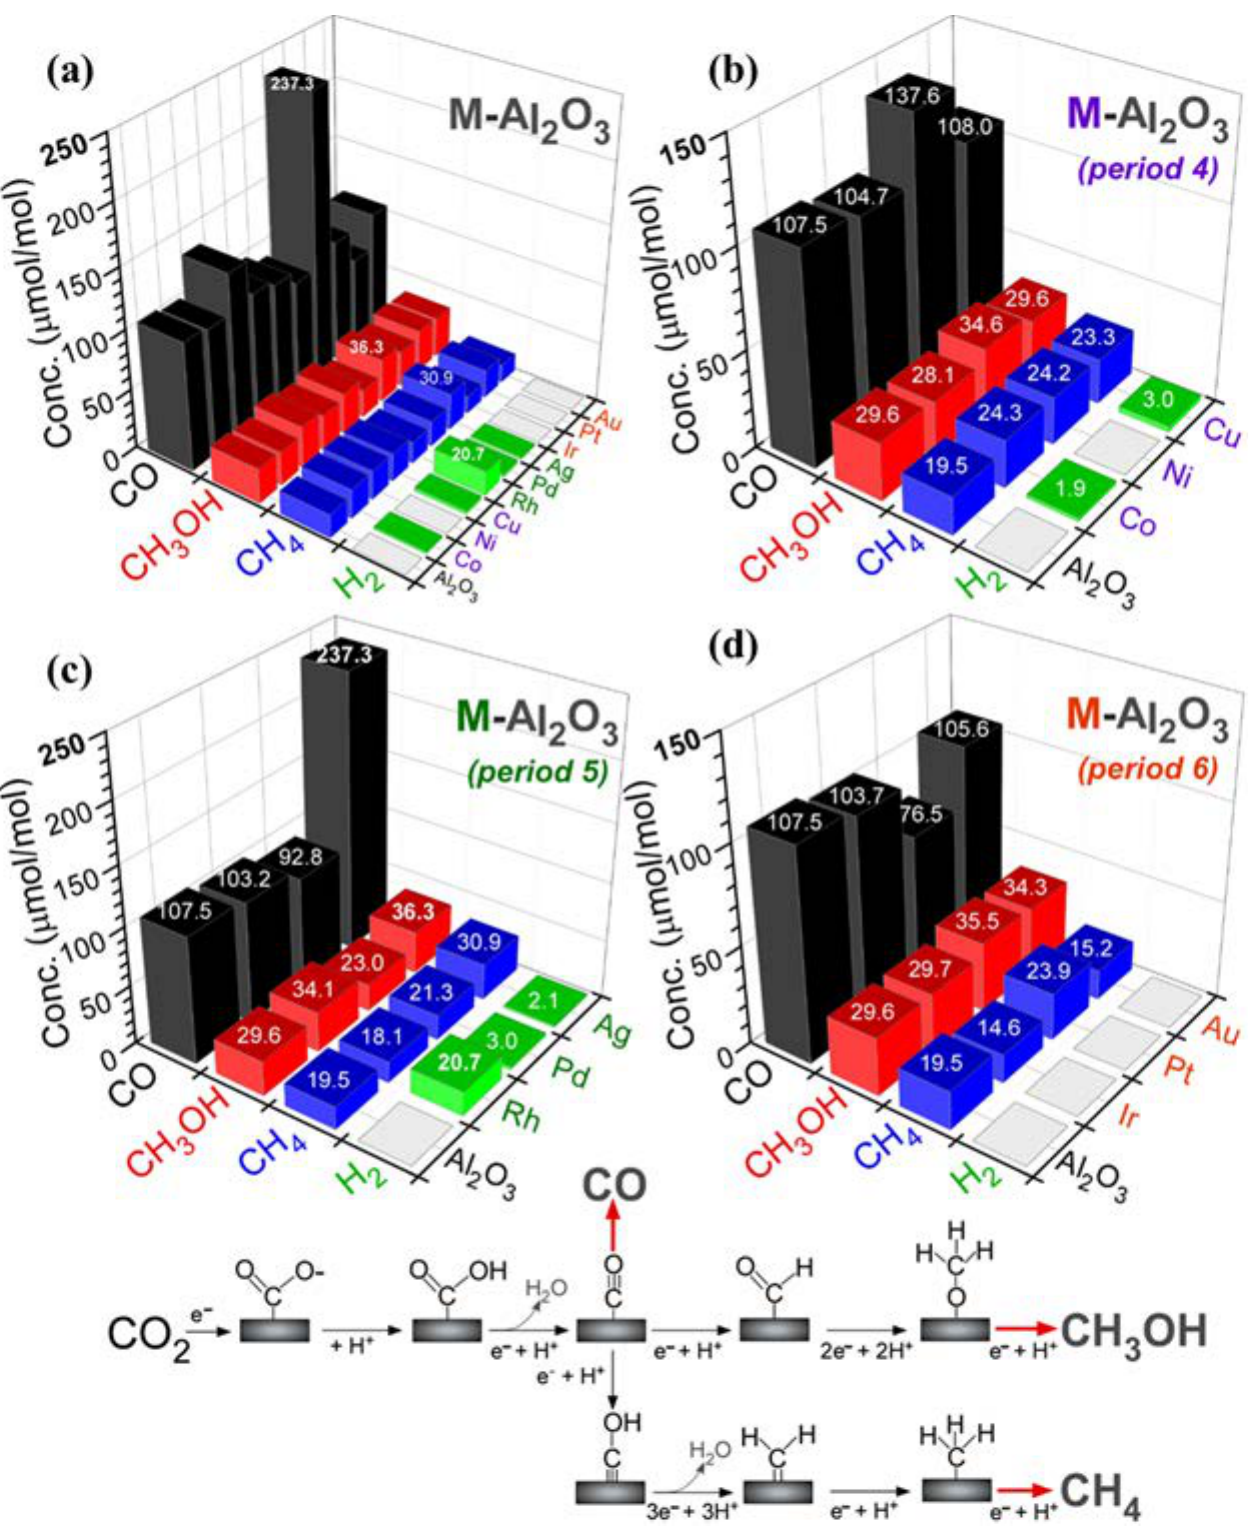
Figure 6. CO 2 reduction CO, CH 4 , and CH 3 OH yields ( µ mol/mol) over bare and M-loaded Al 2 O 3 nanosheets ( a ), (Co, Ni, and Cu)-Al 2 O 3 ( b ), (Rh, Pd, and Ag)-Al 2 O 3 ( c ), (Ir, Pt, and Au)-Al 2 O 3 ( d ), and CO 2 reduction